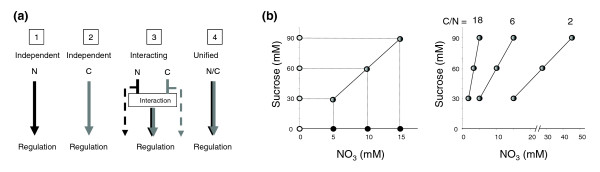
Experimental design to investigate C and N interactions. (a) Hypothetical models to explain regulation by C and N metabolites. The four possible models of gene expression response to N and C treatments are illustrated. Model 1 (N independent of C) represents genes that are regulated by N in a manner that is independent of the amount of C present. Model 2 (C independent of N) is equivalent to model 1 but for C. Model 3 represents different types of interactions between C and N. Model 4 represents regulation by the ratio of C/N. In this case, neither C nor N can affect gene expression. Regulation according to all models could be positive or negative, but only positive examples are depicted. (b) Systematic experimental space to investigate C and N interactions. To investigate gene responses to C and N, we used experiments where plants were exposed to C, N or C+N. The graphs summarize the experiments carried out. Each point in the graphs corresponds to one experiment. The x-axis indicates the concentration of nitrate used (nitrogen source) in the experiment. The y-axis indicates the concentration of sucrose used (carbon source) in the experiment. For example, points on the x-axis correspond to experiments in which plants were treated with nitrate in the absence of sucrose.